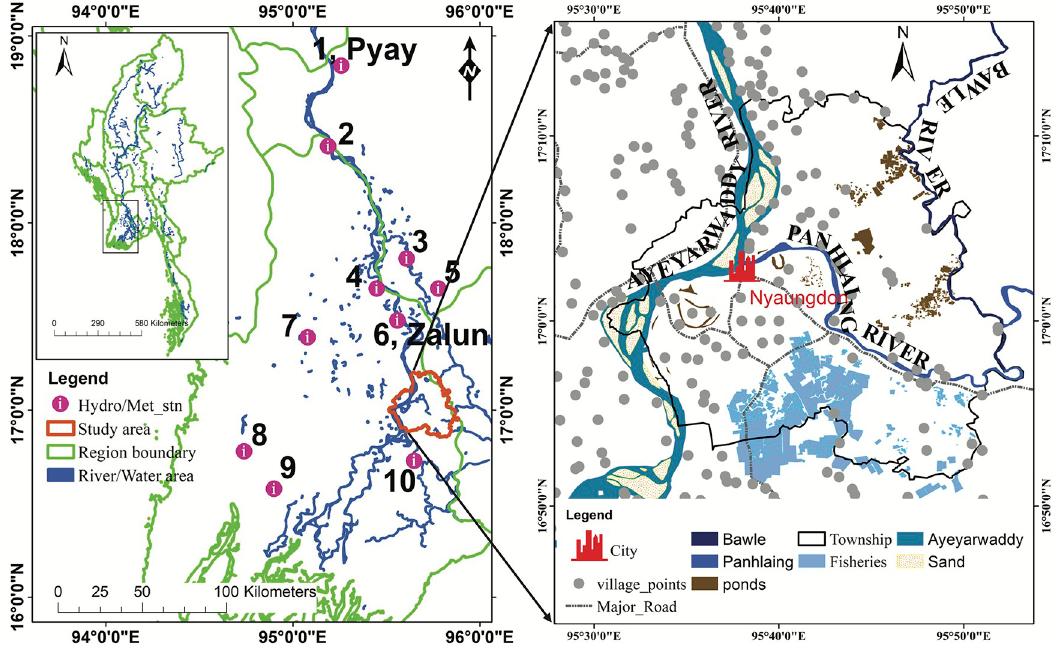
Fig 1. Locations of study area and the hydrological and meteorological observation